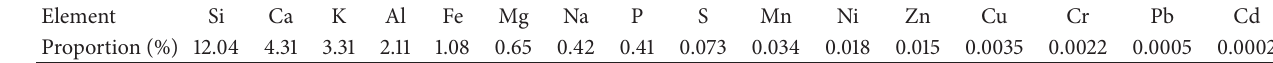
Table 1: Elemental composition of biomass ash analyzed by ICP-OES. Element Si Ca K Al Fe Mg Na